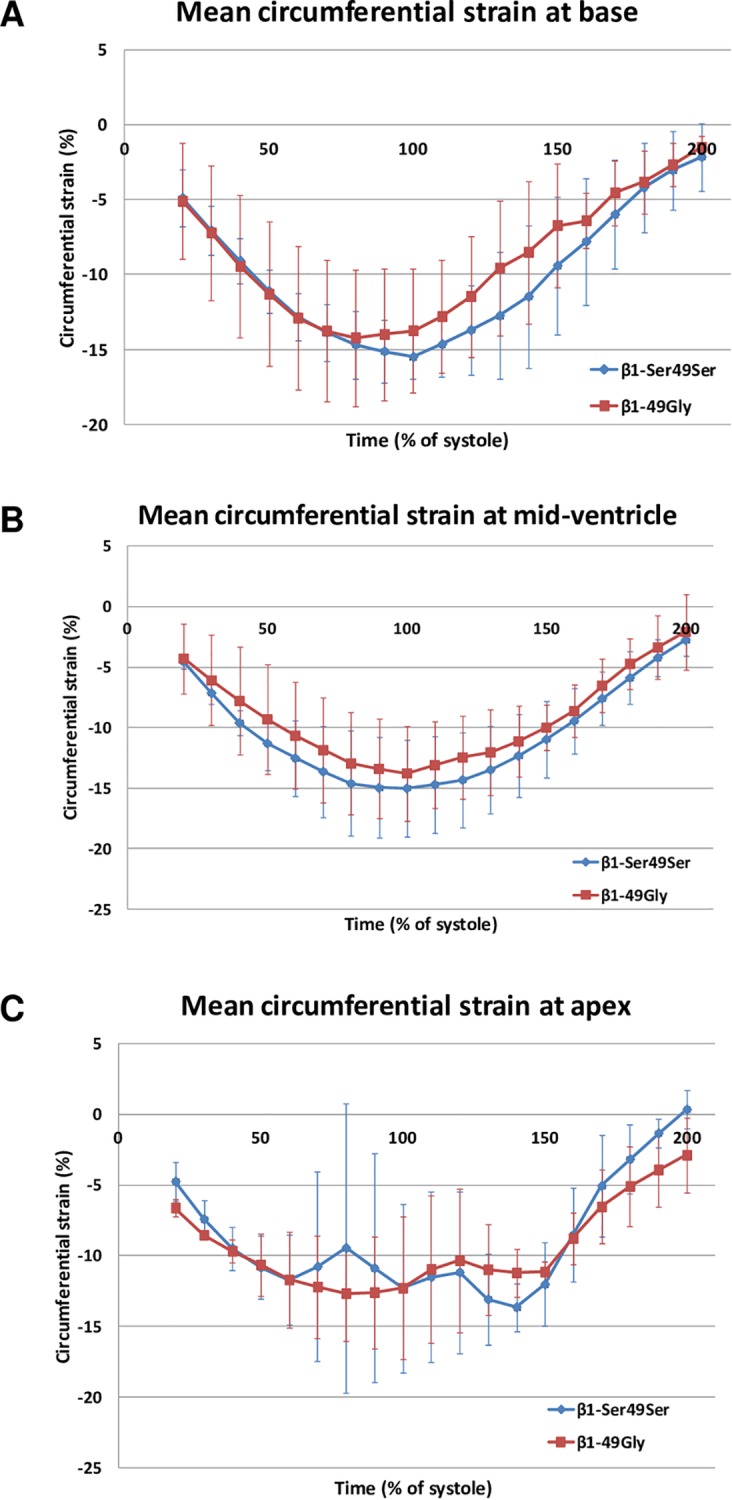
Mean circumferential strain at basal, mid-ventricular and apical slices of the left ventricle comparing β1-AR Ser49Ser and β1-Gly49 carriers along the cardiac cycle.The strain values were obtained using HARP analysis on tagged images acquired with a SF bSSFP CSPAMM tagging technique. All measurements were adapted to the systole duration of each exam. No statistically significant difference could be found between the two groups.